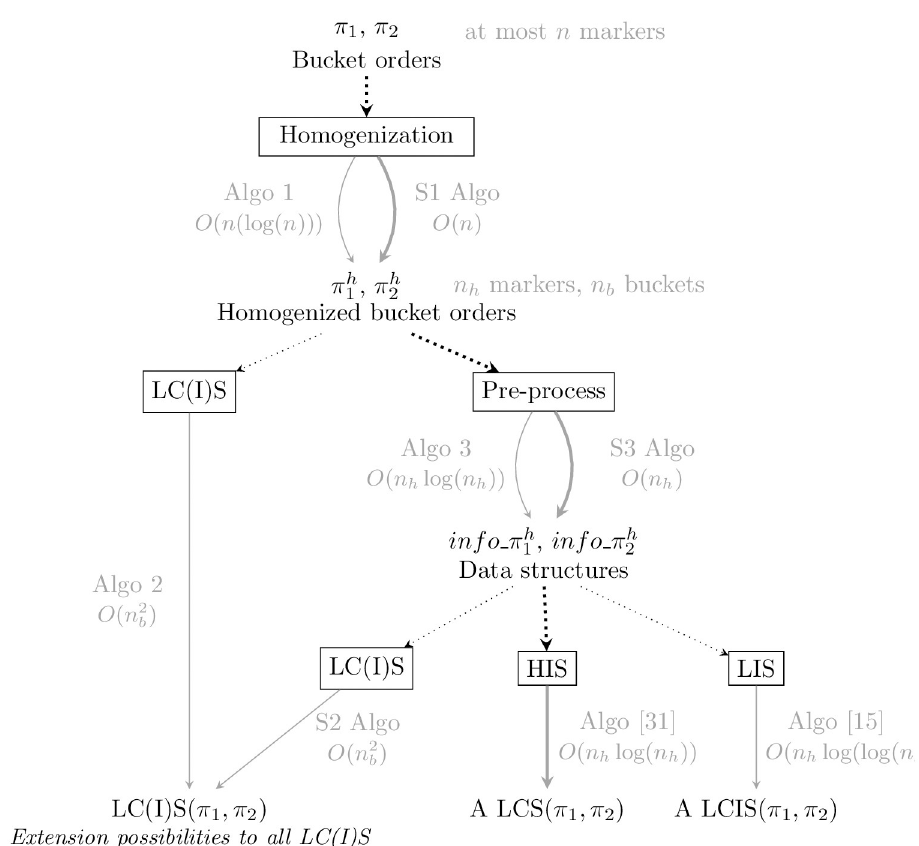
Fig 4. A graph summarizing algorithmic contributions on bucket orders. Each root to tip path of this graph provides a pipeline that chains algorithms to obtain the LCS, the LCIS, or both the LCS and LCIS of 2 input bucket orders π 1 and π 2 . The framed nodes of this graph represent the computation steps while the other nodes are the input and/or output of those steps. The algorithms that can be used at each computation step, together with its complexity for this specific task are shown in grey. Note that we count only the time complexity of the specific part of each algorithm. For example, Algorithm 2 calls an algorithm for the Homogenization part, which we don’t count here, as it appears higher on the path. The overall time complexity of a pipeline to get a LCS/LCIS of π 1 and π 2 is the sum of the complexities encountered along the corresponding root to tip path. For example, the time complexity of the pipeline that returns a LCS( π 1 , π 2 ) by chaining S1 and S3 Algo and HIS algo [31] (thick arrow path) is O ( n ) + O ( n h ) + O ( n h log( n h )) = O ( n log( n